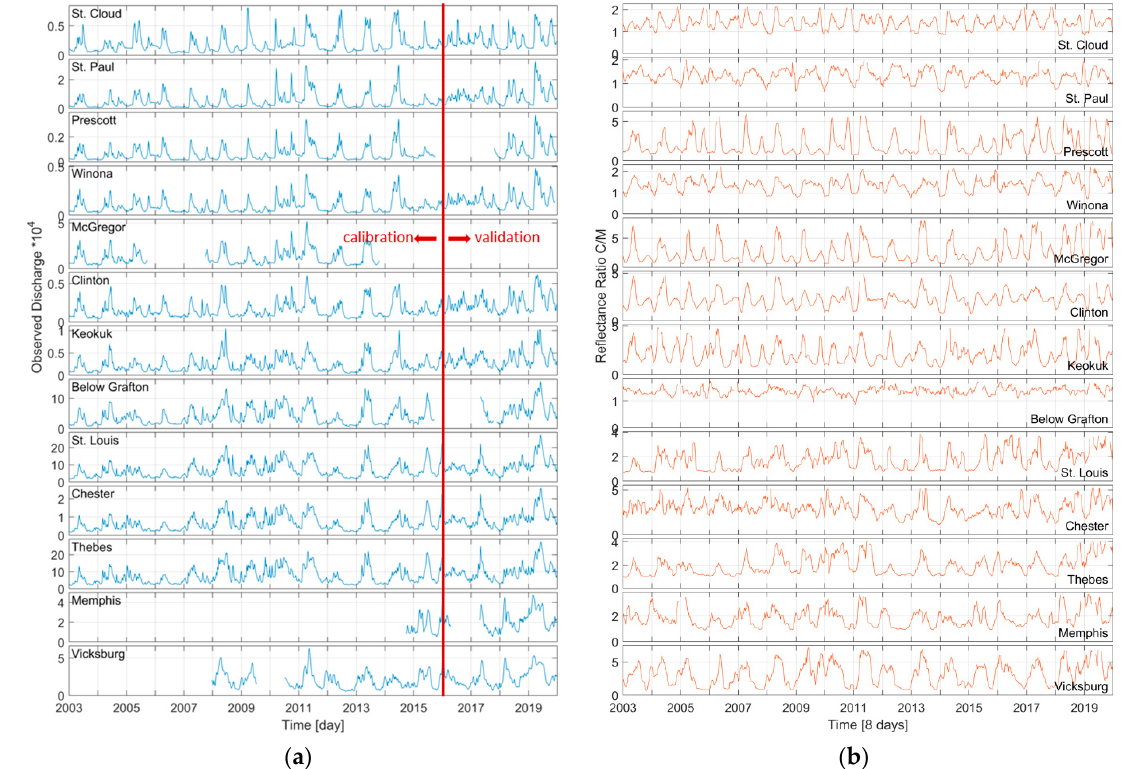
Figure 2. River discharge hydrograph ( a ) and reflectance ratio C/M ( b ) for the selected in-situ gauged stations. Table 1. List of the in-situ gauged stations along the Mississippi River selected for the analysis (latitude, Lat.; longitude, Lon.; basin area, A b ) and their characteristics (percent of missing data; minimum, maximum and mean river discharge: Qmin, Qmax, and Qmean, respectively) extracted for the period January 2003 to December 2019.